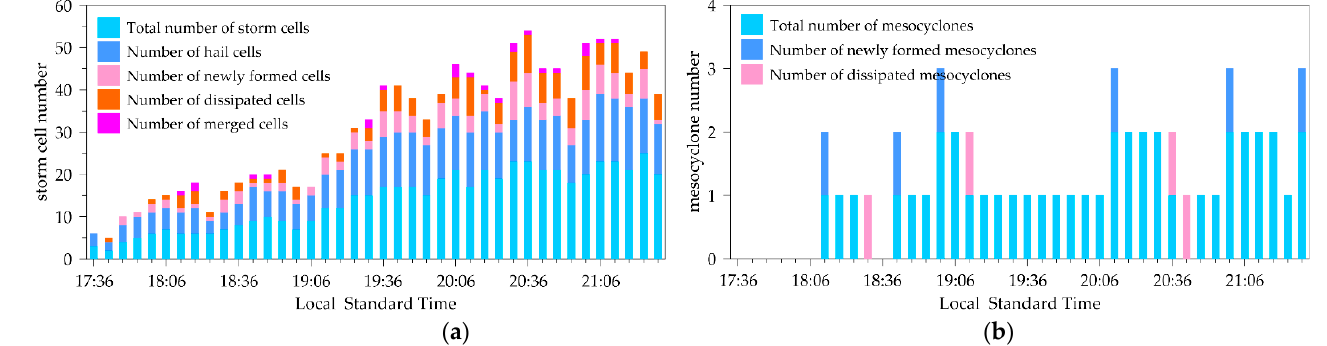
Figure 7. Temporal variation of the number of both storm cells ( a ) and mesocyclones ( b ) matching Convective System 1 from 1736 to 2130 LST on 26 Apr 2019.